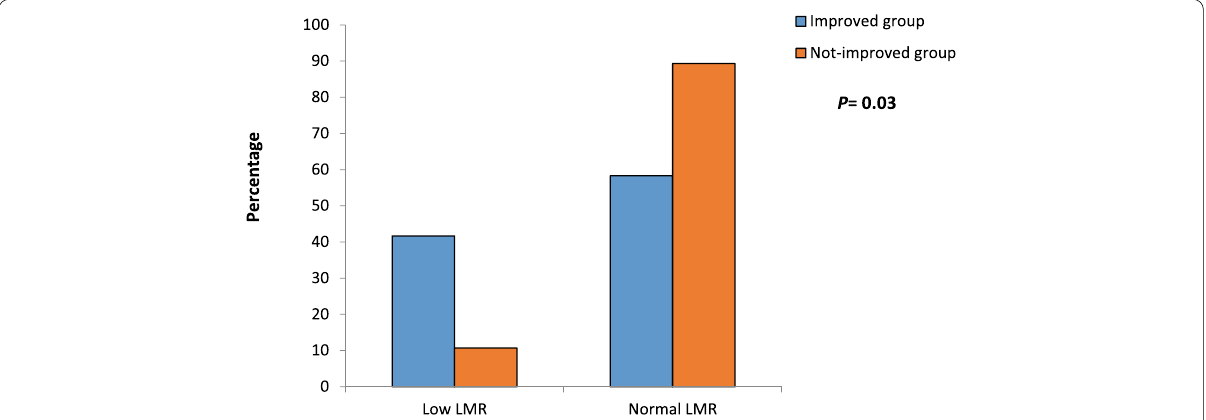
Fig. 4 Lymphocytes:monocytes ratio based on outcome of studied